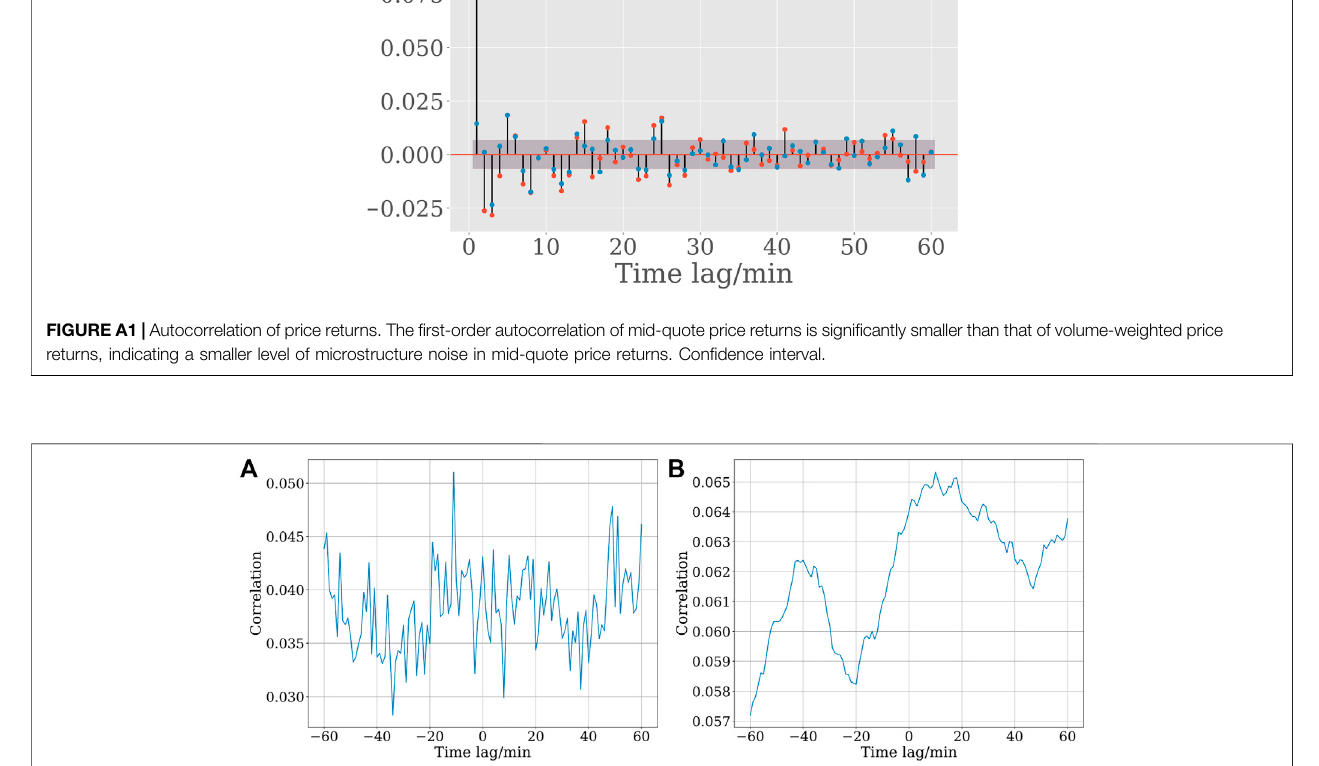
FIGURE A2 | (A) Correlation between squared price returns and Twitter volume. Permutation signi fi cance check indicates no statistically signi fi cant correlation between time-permuted squared price returns and Twitter time series. (B) Correlation between squared price returns and integrated Twitter volume (over a 30-min moving window). This test is only used to check whether the integrating operator is fi ltering noise. Correlation between squared price returns and Twitter time series. All values of correlation are statistically signi fi cant ( p -value ≤ 0 .